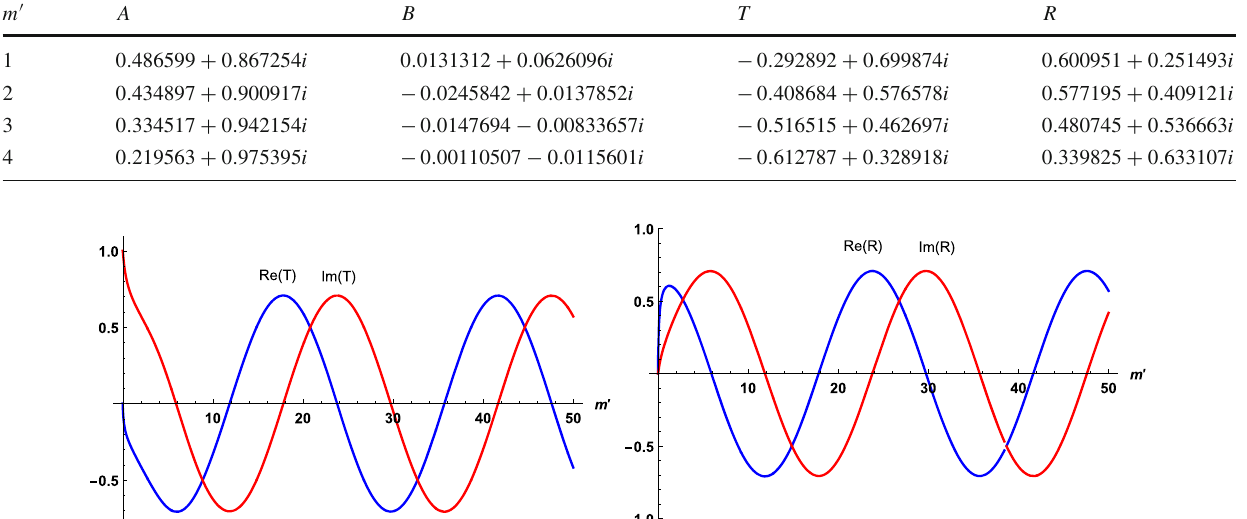
Table 2 Scattering coefficients for real momentum scenario